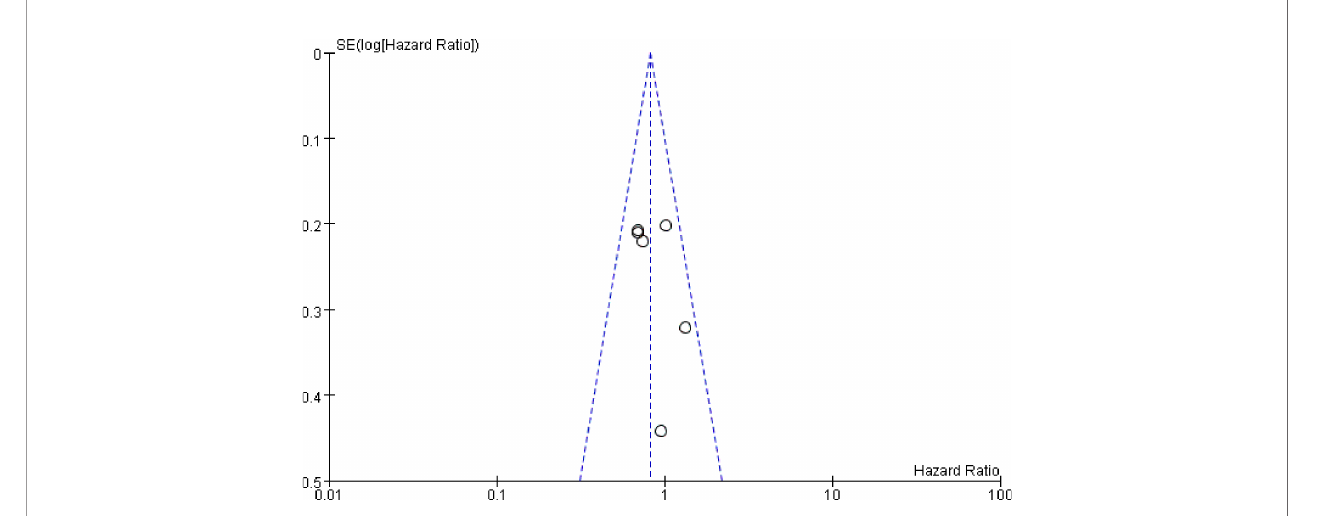
FIGURE 6 | The funnel plot was used to measure the publication